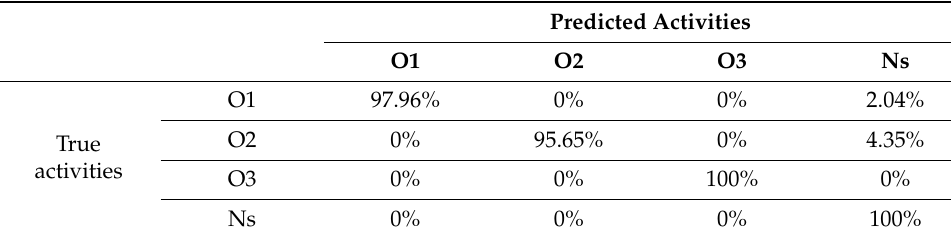
Table 5. The confusion matrix of four activities: stationary (O1), ascending (O2), descending (O3), and combined walking